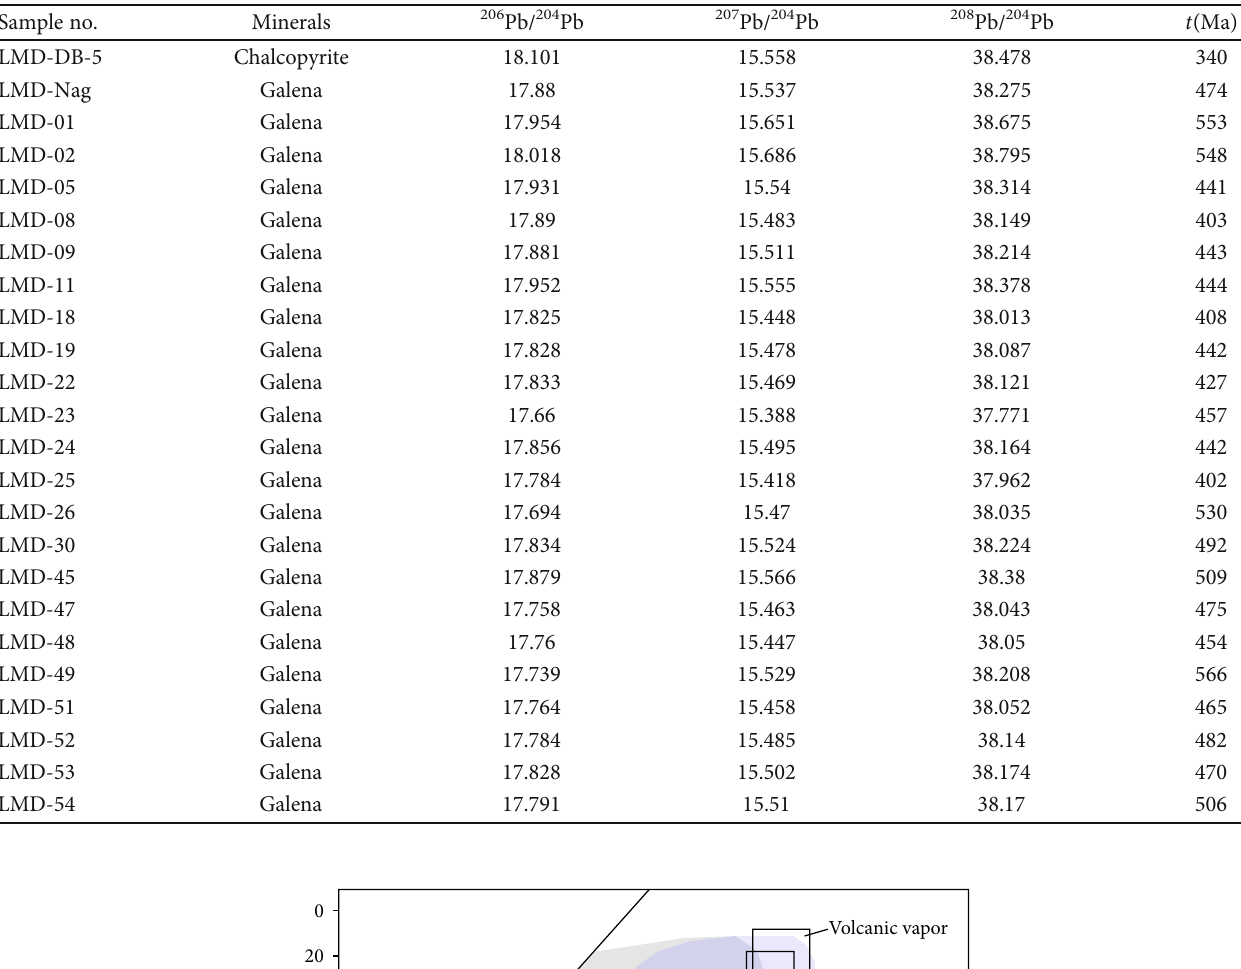
Table 6: Lead isotope compositions of sul fi des from the Longmendian Ag-Pb-Zn deposit. Sample no.